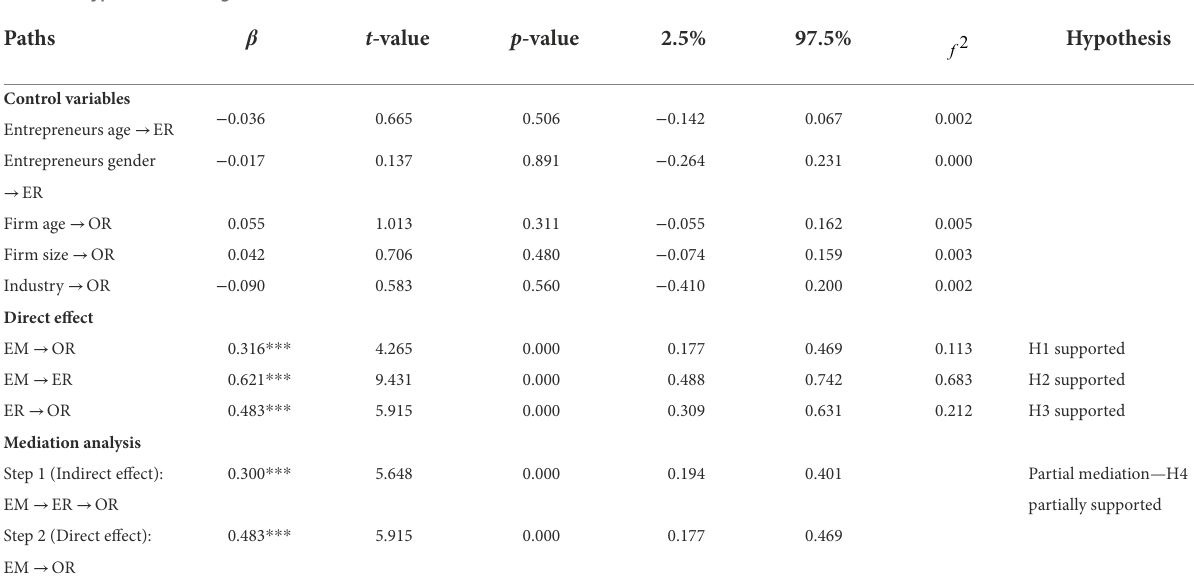
FIGURE 1 Full model analysis results. **** p < 0.001.